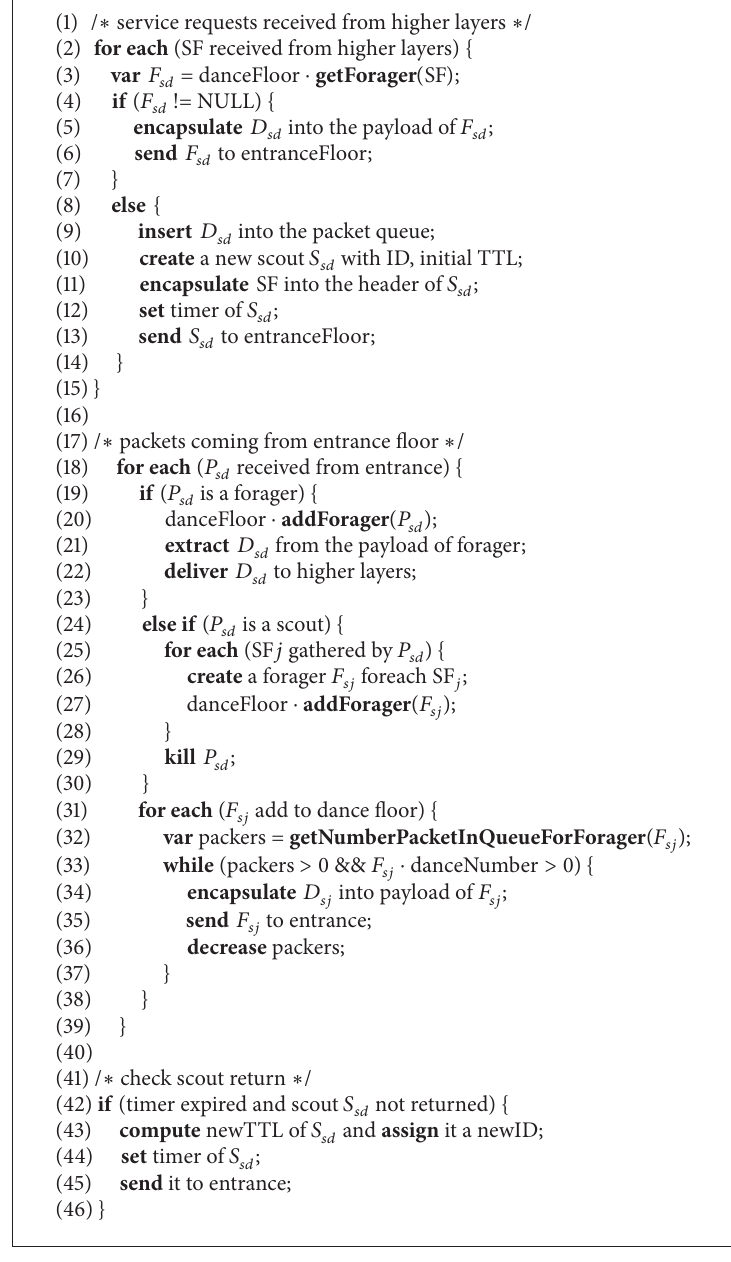
Algorithm 2: Actions taken at the Packing